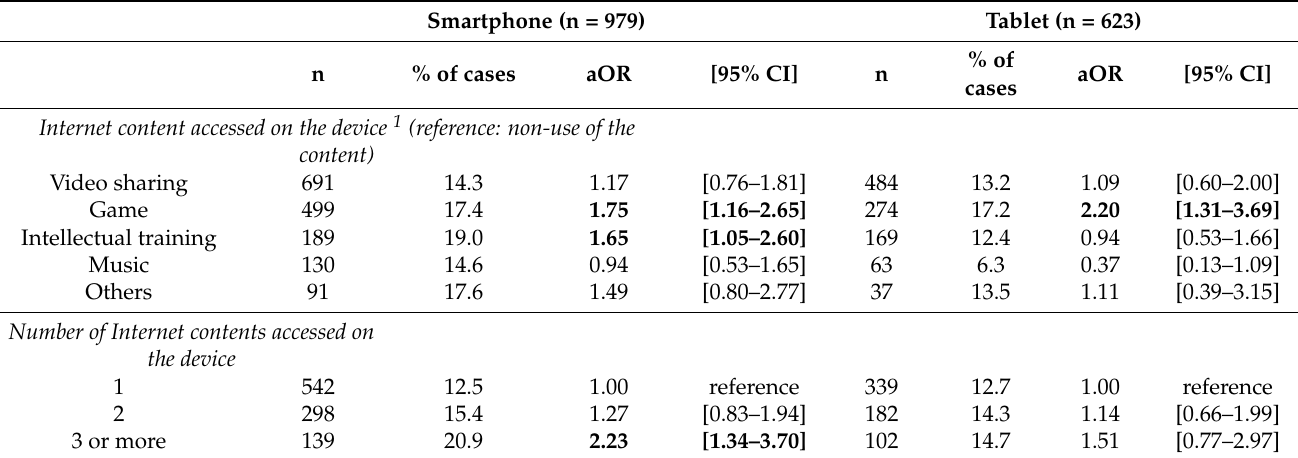
Table 5. Associations between children’s delayed bedtime (after 22:00 h) and types of Internet content accessed on smartphones or tablets among Internet users on the